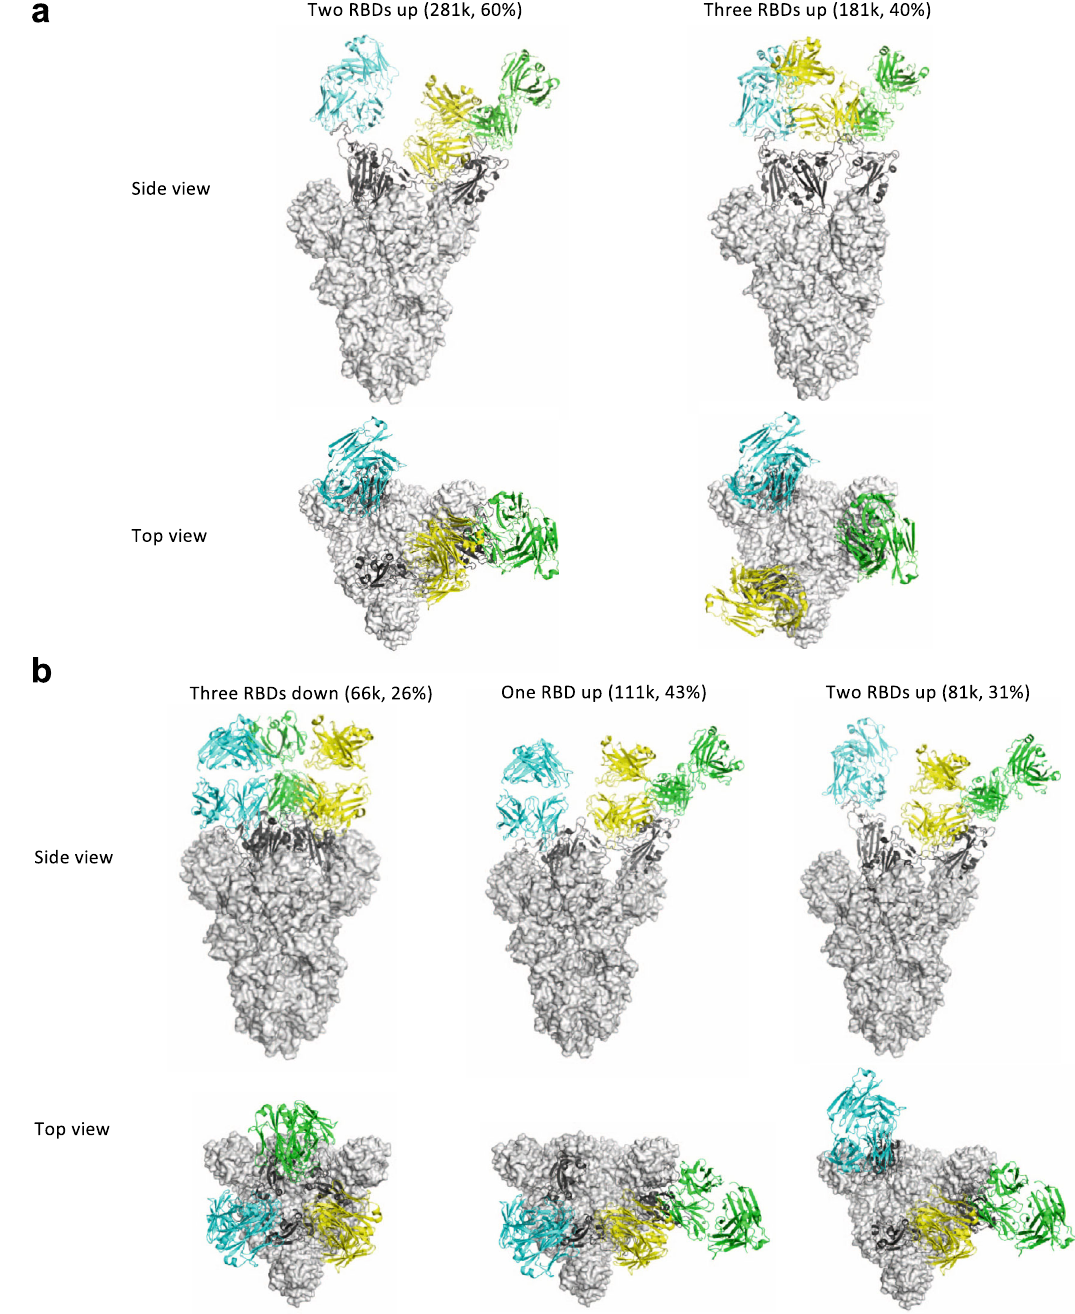
Fig. 2 Cryo-EM structures of the ectodomain of SARS-CoV-2 spike trimer in complex with Clone 2 or Clone 6 Fab and Structural comparisons. a , b Cryo-EM structures of the ectodomain of SARS-CoV-2 spike trimer in complex with Clone 2 ( a ) or Clone 6 ( b ). Each Fab molecule is shown as ribbons in different colors, spike RBD is shown as dark gray ribbons, with the rest of spike trimer shown as gray surface. The particle distribution of each S trimer conformation is shown